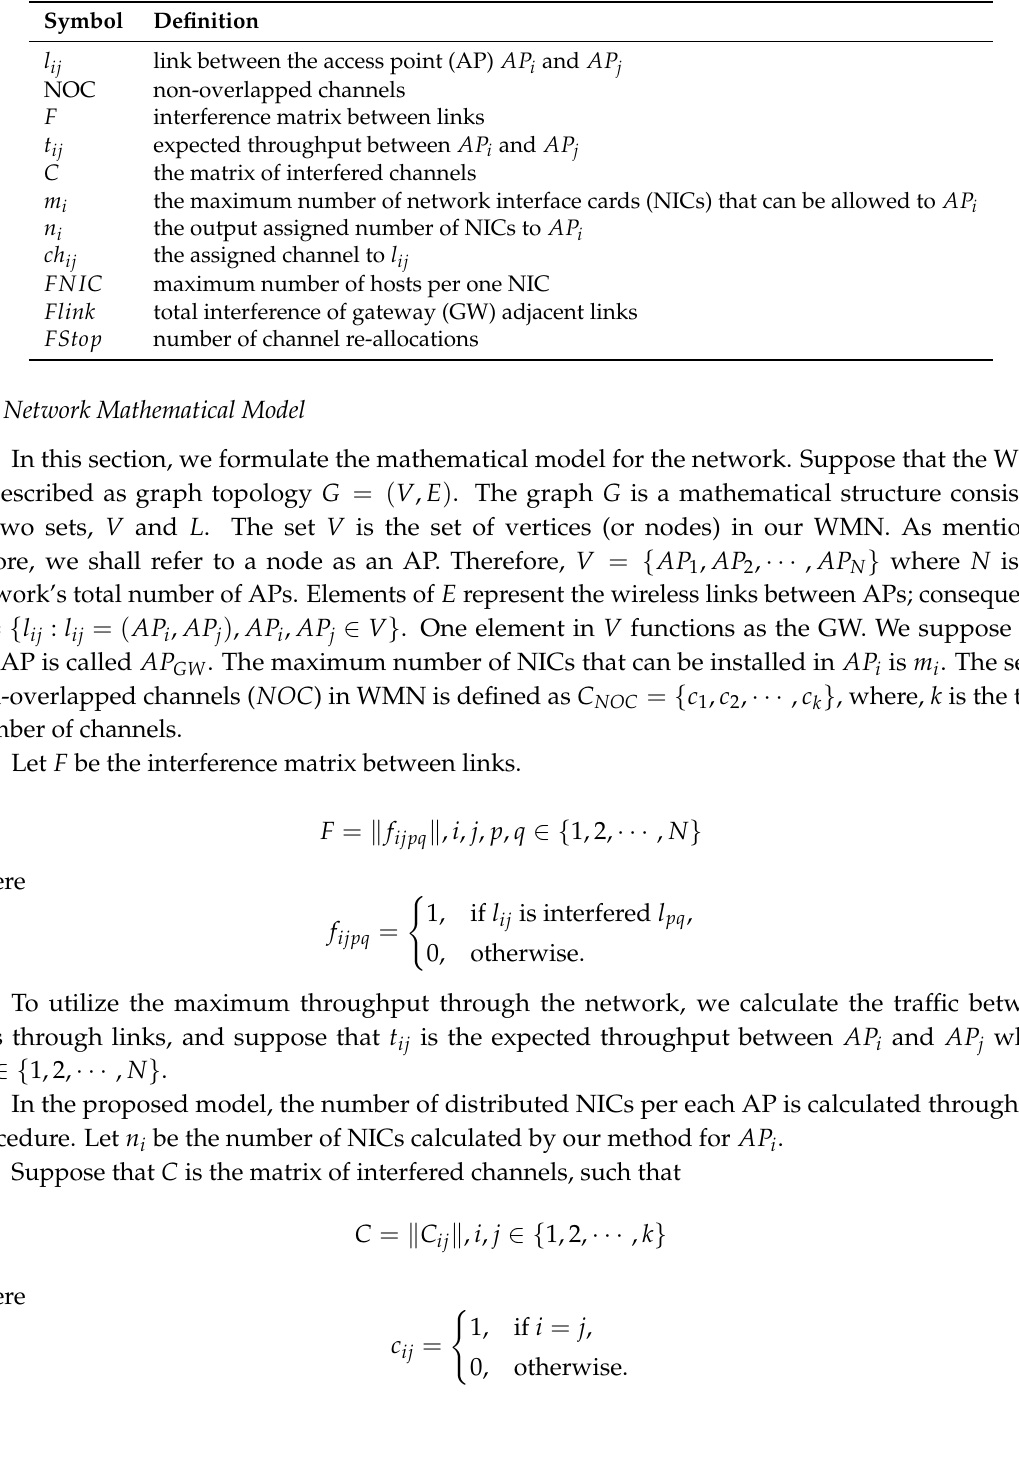
Table 1. Formulation